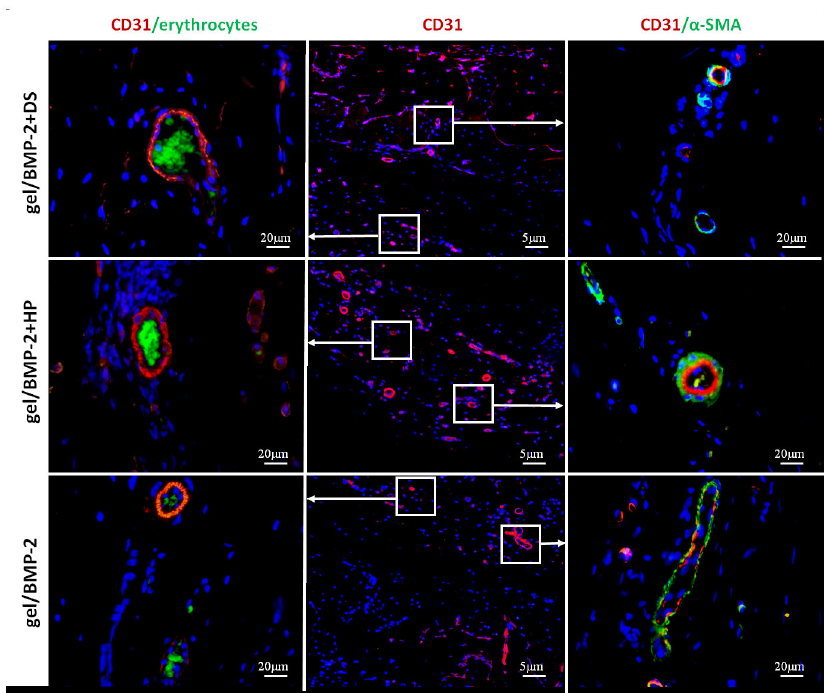
The cross sections of ectopic bone formed due to gel/BMP-2+DS, gel/BMP-2+HP and gel/BMP-2 were immunostained with CD31 (red) and α-SMA (green in right panel). The erythrocytes were visualized by green autofluorescence (green in left panel). The area showed in middle panel corresponds to area indicated in Figure 5. Cells nuclei were stained with DAPI (blue). The images are shown